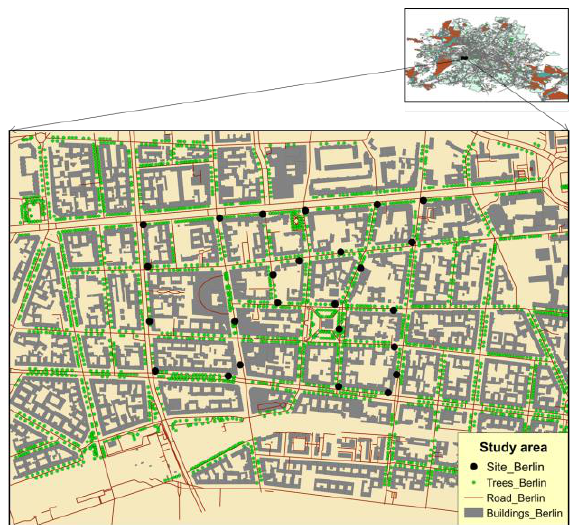
Figure 1. Research area in the middle of Berlin. Black dots indicate measurement sites and buffer centres, respectively (adopted from Ghassoun and Löwner